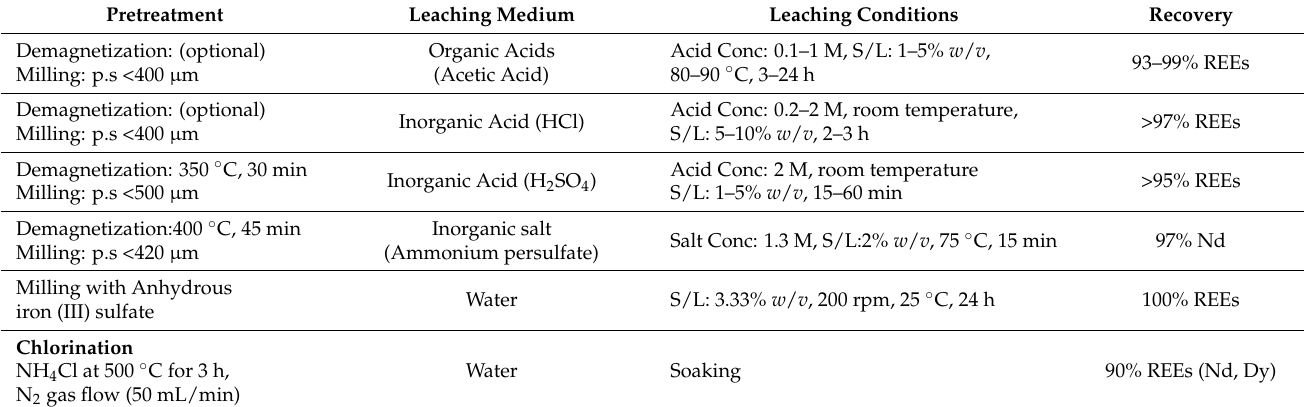
Table 6. Recovery yields of REE from NdFeB permanent magnets for different leaching mediums and